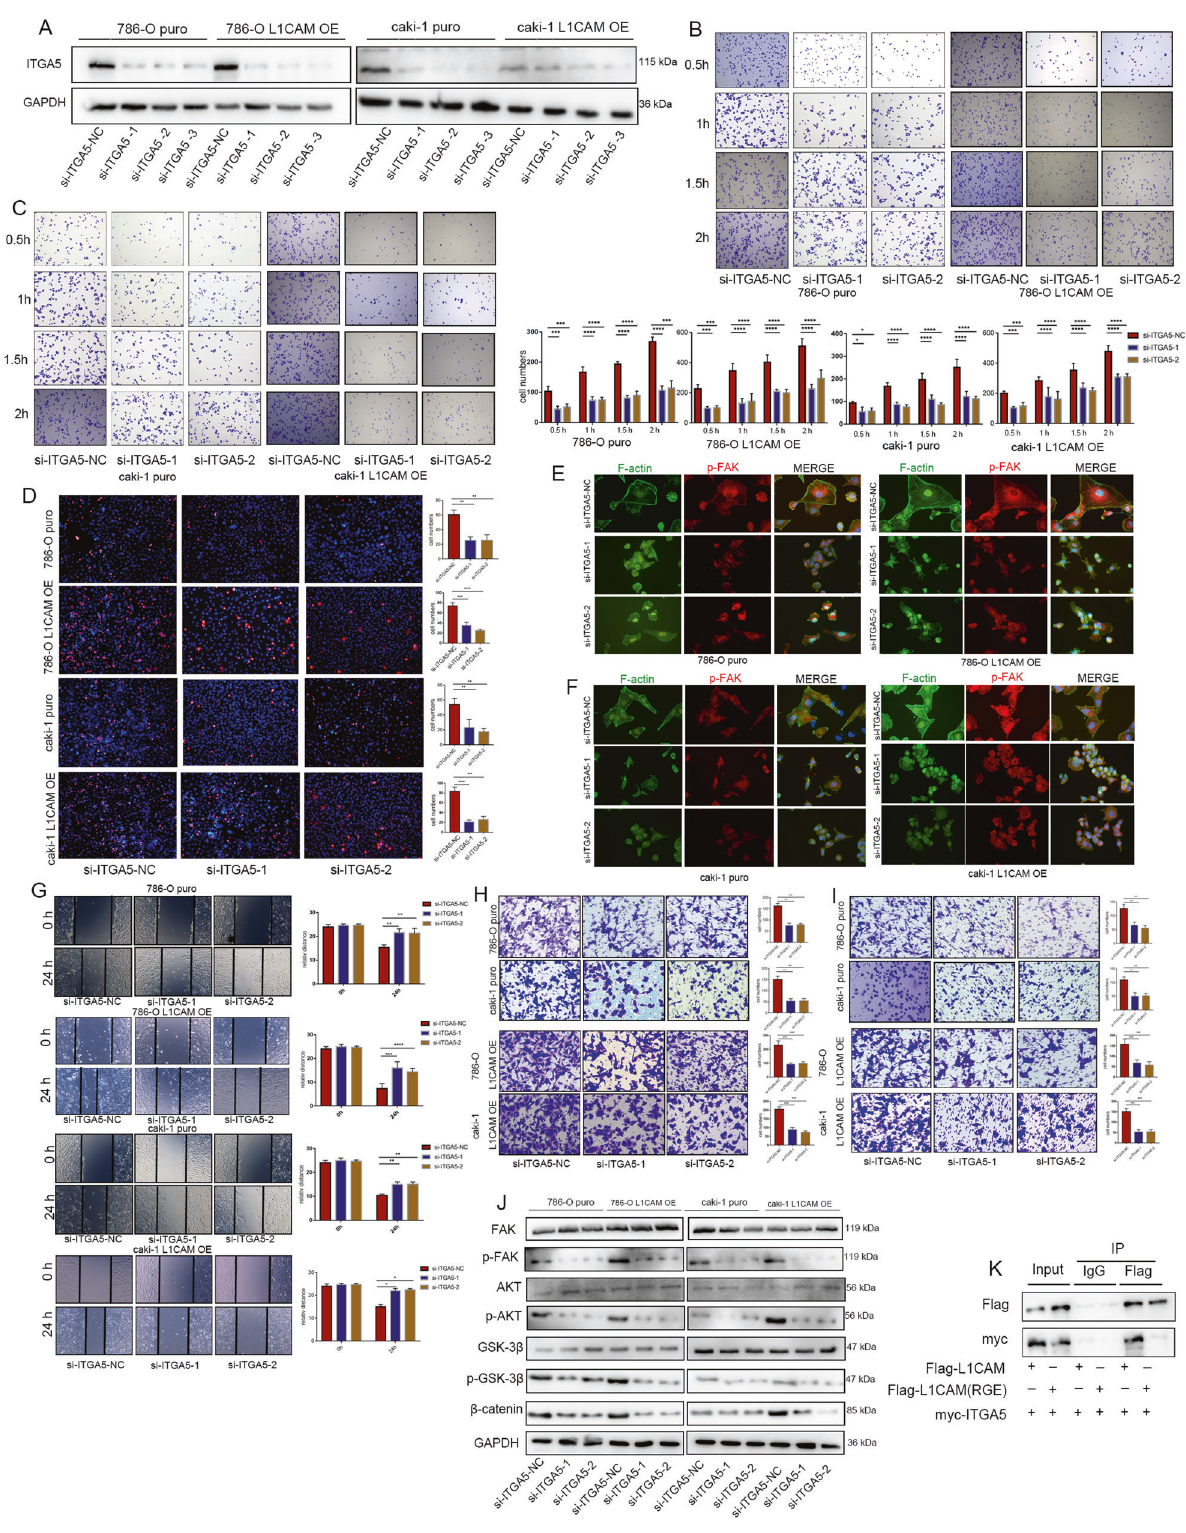
Fig. 7 Inhibition of ITGA5 expression rescues the effects of L1CAM on the malignant behaviors of RCC cells. A Protein expression levels of ITGA5 in 786-O and Caki-1 cells after siRNA knockdown. B – D ECM adhesion and tumor-endothelial adhesion assays were used to assess the adhesion activity of RCC cells. E , F Immuno fl uorescence of F-actin stress fi ber formation and focal adhesion complex assembly (400× magni fi cation). G – I Wound healing, Transwell migration, and invasion assays were performed to assess the migration and invasion activity of RCCs. J Activation of protein kinases in integrin α 5 β 1 signaling after inhibition of ITGA5 expression. K IP and Western blotting after co- transfection with FLAG-tagged L1CAM or FLAG-tagged L1CAM-RGE and Myc-tagged ITGA5. Data are presented as mean ± SD. * P < 0.05, ** P < 0.01, *** P < 0.001, and **** P < 0.0001.